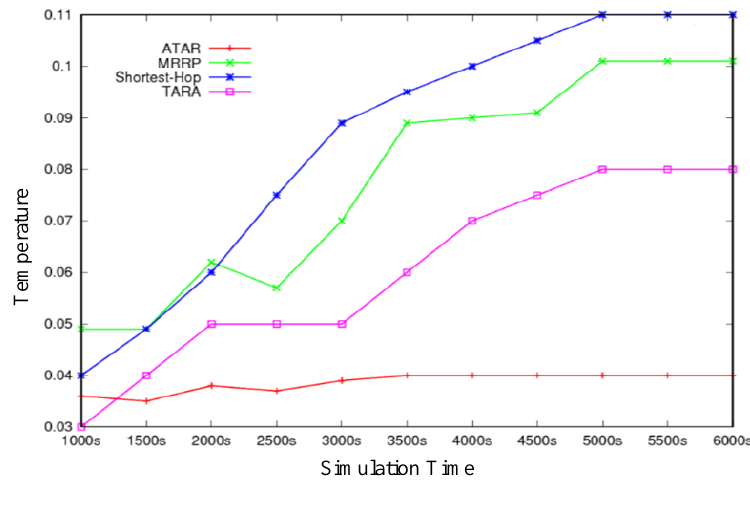
Figure 16. Average temperature rise versus simulation time.